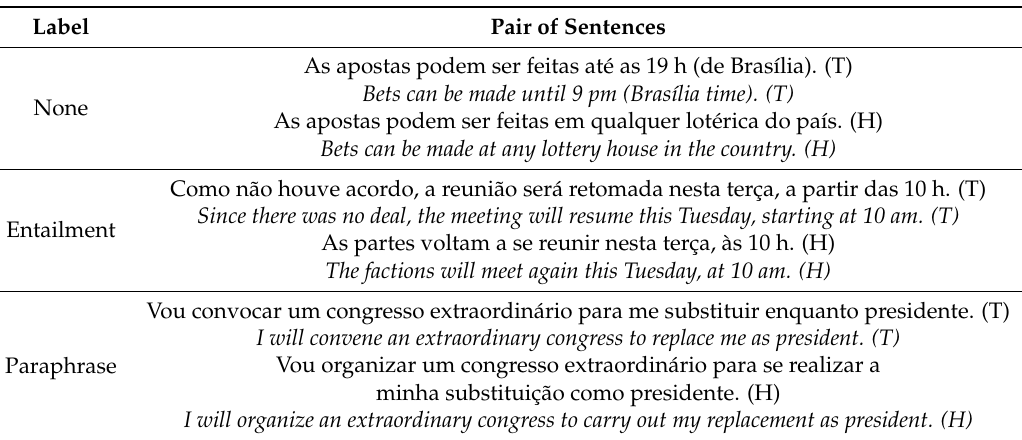
Table 3. Annotated examples from the ASSIN corpus (extracted from